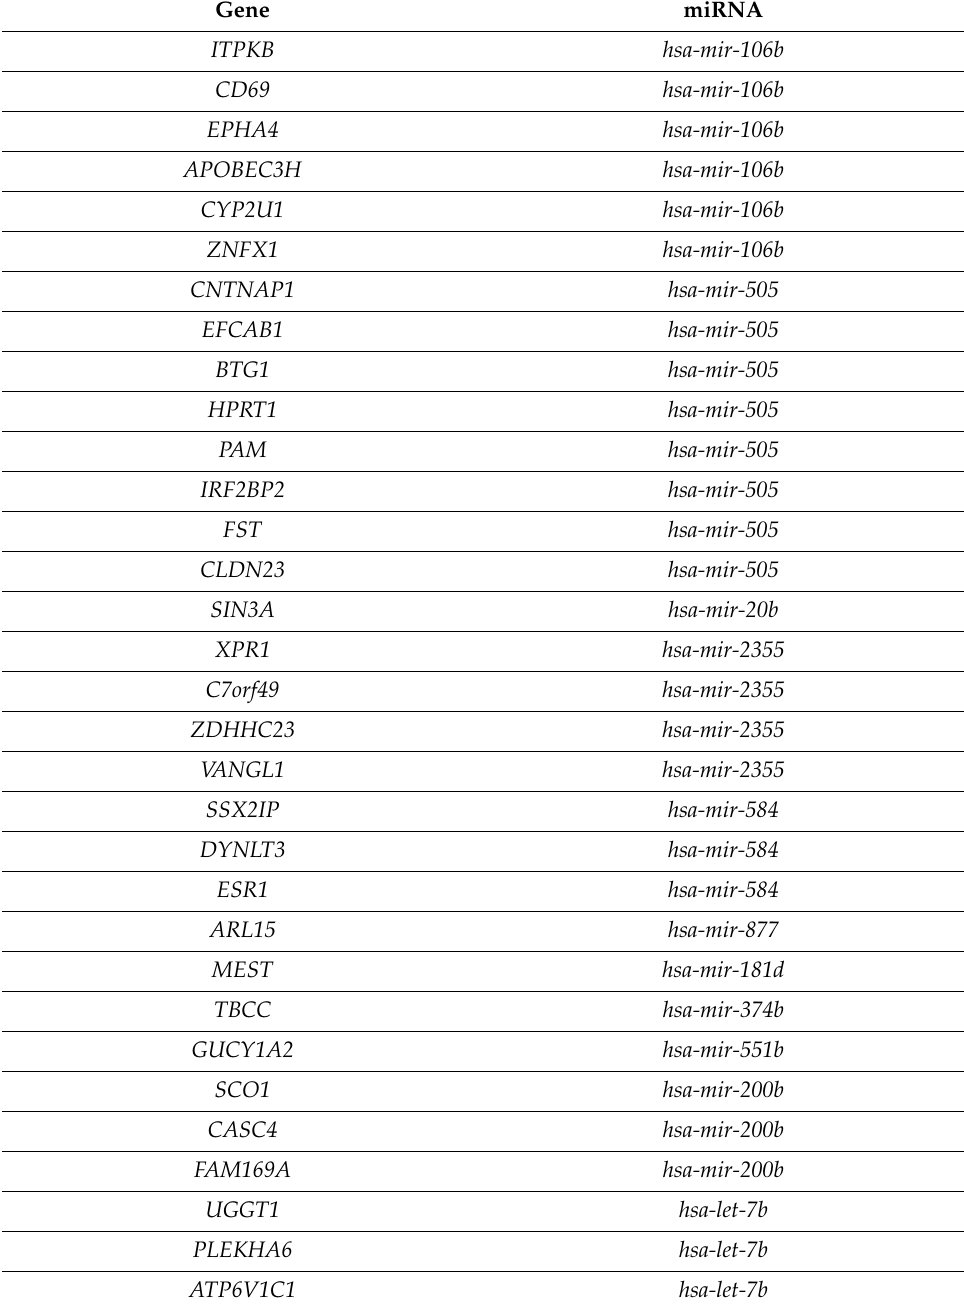
Table 3. The list of matched miRNAs upregulated in human with nonalcoholic fatty liver disease (NAFLD) and their targeted